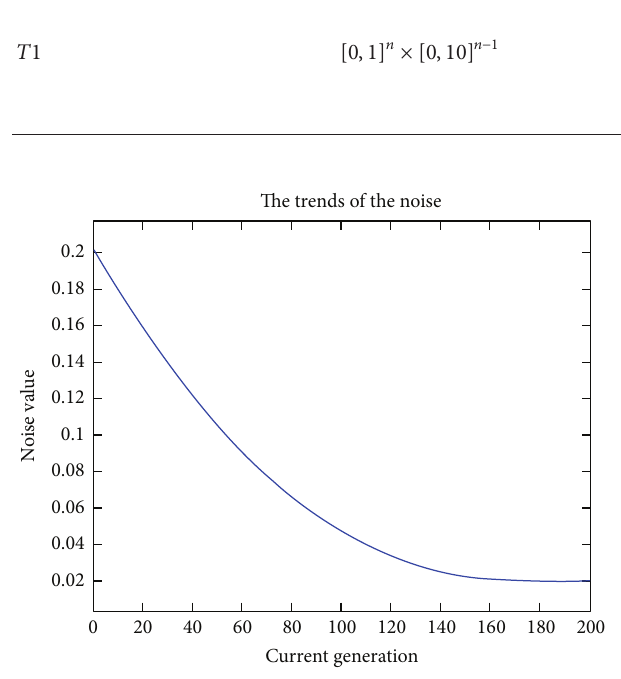
Figure 6: The trends of the